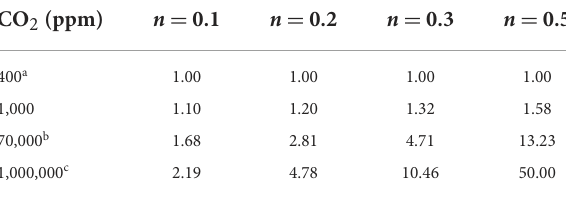
TABLE 5 Weathering rate factor α = ( p CO the baseline condition of 400 ppm CO 2 as applied in common Earth system models to simulate weathering rate changes with increased